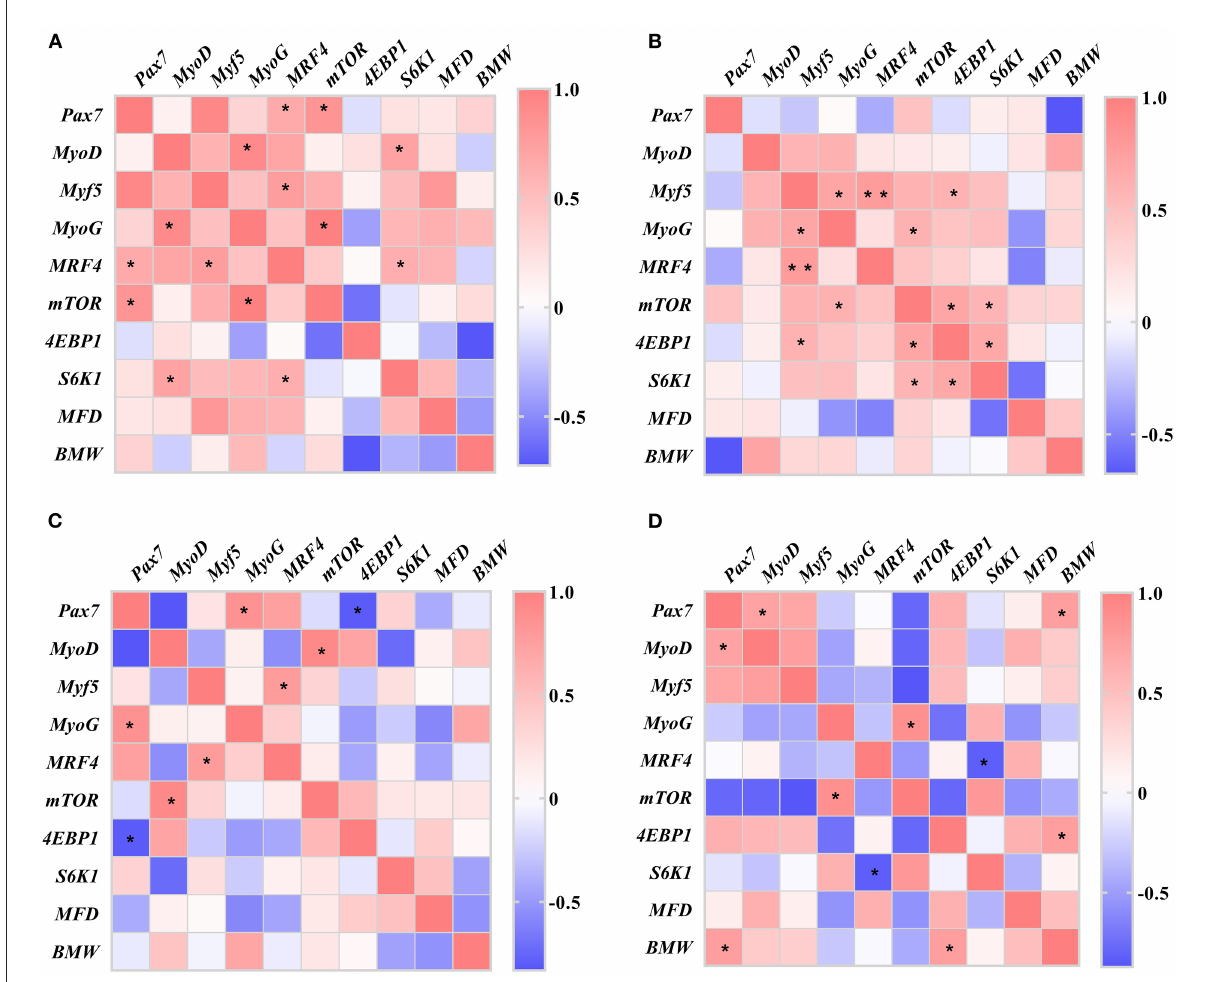
FIGURE5 Heatmaps of correlation between the breast muscle characteristics and genes of muscle development in slow-growing chickens. (A) Day of hatching; (B) day 21; (C) day 42; (D) day 63. Pax7 , paired box 7; MyoD , myogenic differentiation 1; Myf5 , myogenic factor 5; MyoG , myogenin; MRF4 , myogenic regulator 4; mTOR , mammalian target of rapamycin; 4EBP1 , eIF4E-binding protein 1; S6K1 , ribosomal protein S6 kinase 1; MFD, muscle fiber diameter; BMW, breast muscle weight. * P < 0.05, ** P <